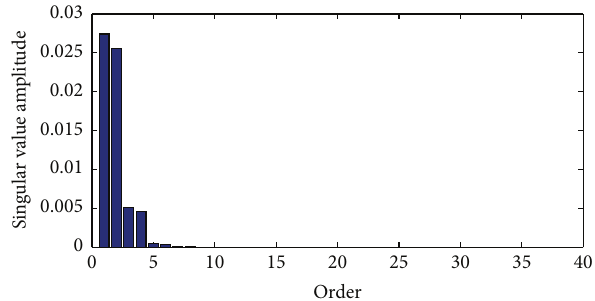
Figure 7: Model order selection (here 2𝑛 = 6